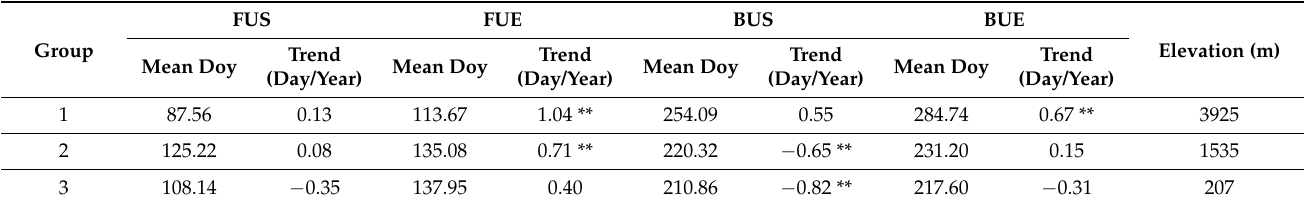
Table 3. Phenology variable change and